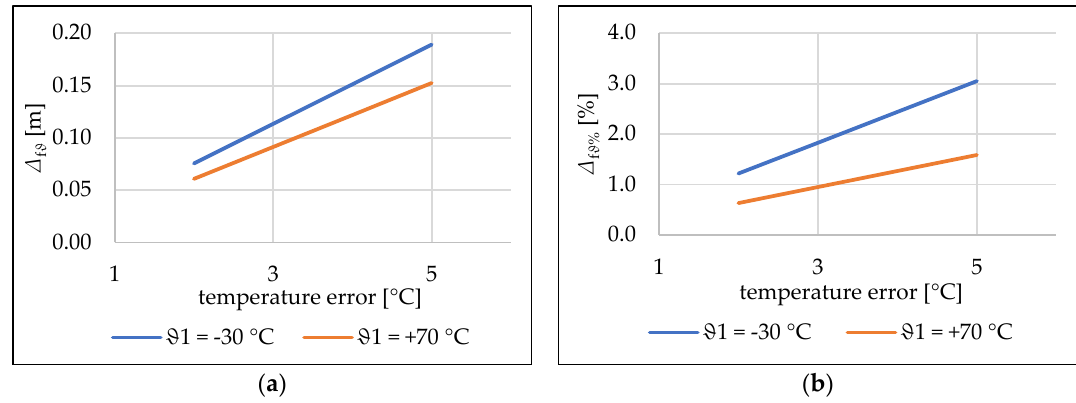
Figure 6. Increase of the sag deviations depending on the magnitude of the error in determining the initial conductor temperature ϑ 0 : ( a ) Absolute sag deviations; ( b ) percentage sag deviations.